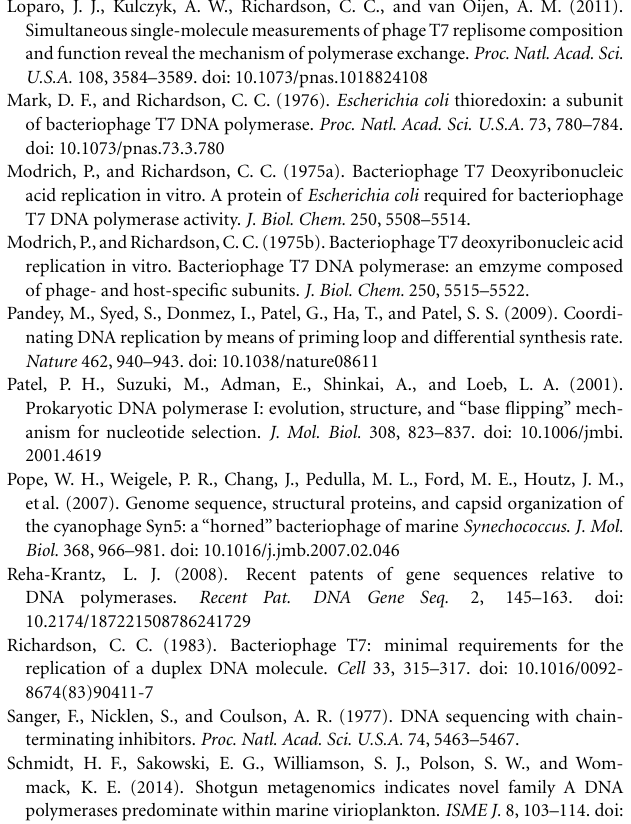
Tabor,S.,andRichardson,C.C.(1989b).Effectofmanganeseionsontheincorpora- tionof dideoxynucleotidesbybacteriophageT7DNApolymeraseand